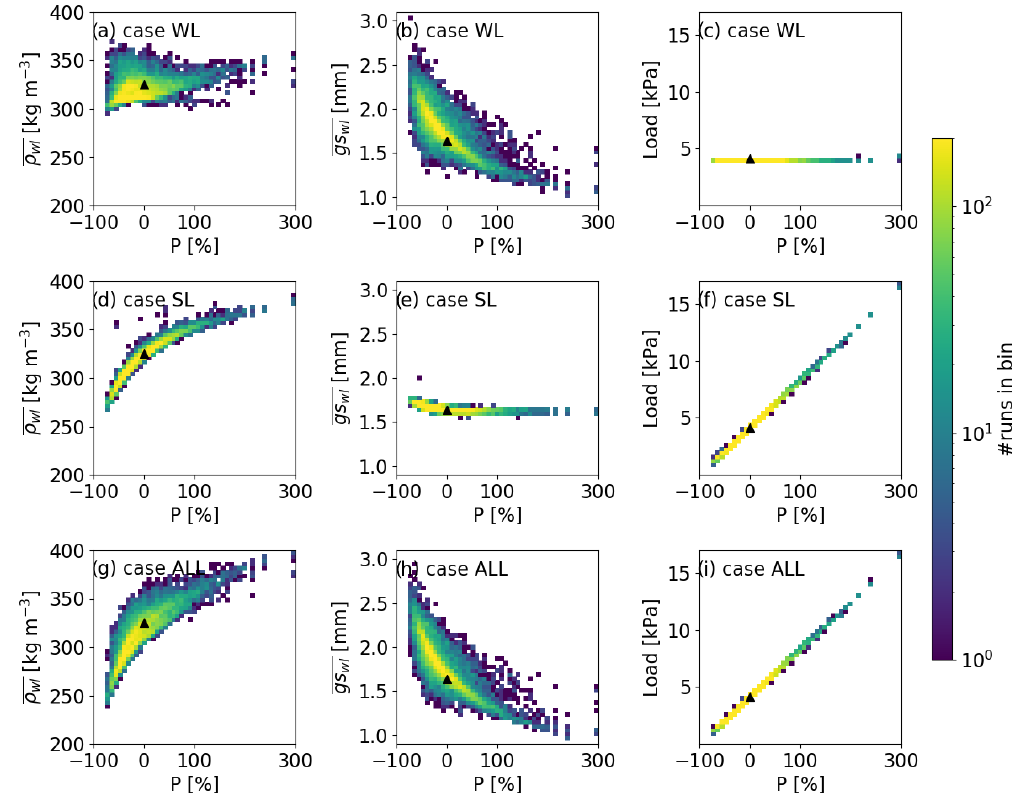
Figure 6. Modeled (a, d, g) weak layer density, (b, e, h) weak layer grain size and (c, f, i) load of the slab with uncertainty in precipitation ( P ) on 9 March 2017 for (a–c) case WL, (d–f) case SL and (g–i) case ALL. Colors indicate the binned number of simulations. Triangles indicate the reference